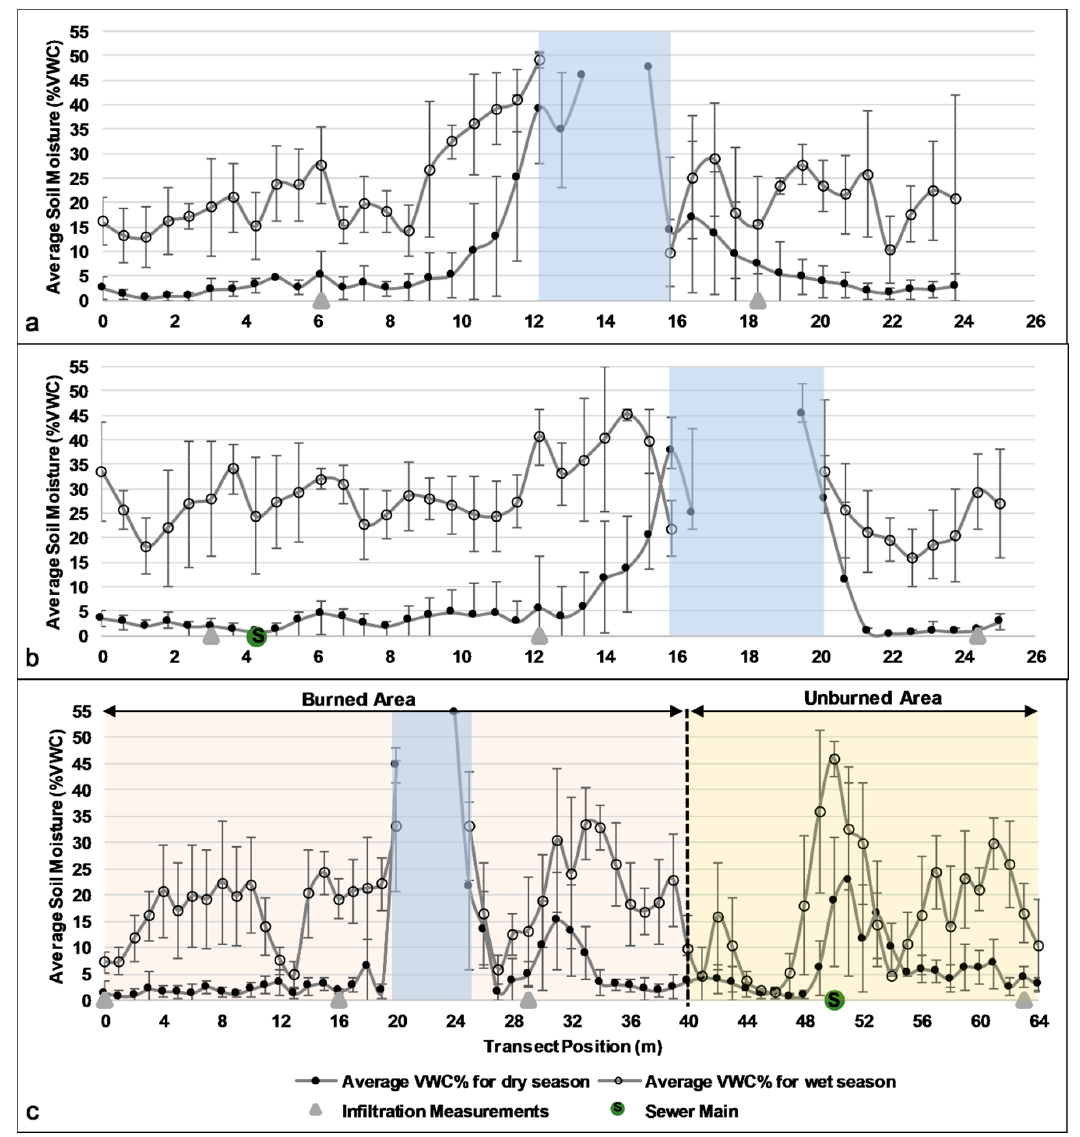
Figure 2. Average soil moisture (%VWC) and standard deviation for each transect position (m) along the unburned pedestrian bridge (PB) transect ( a ), the unburned culvert (CUL) transect ( b ), and Del Cerro (DC) transect from June 30, 2018 to September 21, 2019 ( c ). All transects start from the downstream-facing left bank and end at the downstream-facing right bank. The gray line with black closed circles represents average soil moisture content during the dry season. The gray line with black open circles represents average soil moisture content during the wet season. The vertical grey shading represents the location of the creek, where the width varies between the dry and wet season. The locations of infiltration measurements (solid gray triangle) and approximate location of the sewer main (S) are denoted. The burned and unburned sections of the transect are highlighted for Del Cerro.